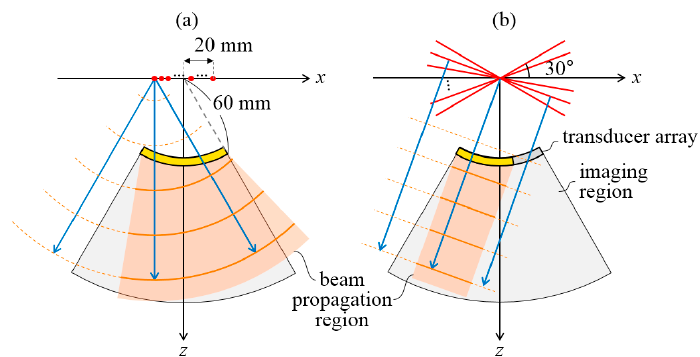
Figure 1. ( a ) Virtual sources (VSs) (red dots) and propagating DW (orange arcs) used for DWI and ( b ) steered PWs (solid red lines) and propagating PW (orange lines) used for PWI. Directions of DWs and PWs are indicated by blue arrows, and transmit apertures are marked with yellow shaded areas. Pixels in the beam propagation region (orange shaded area) for each DW or PW transmission should be reconstructed in the beamforming process. Difference in the size of beam propagation region between DWI and PWI shows the difference in the amount of computations required for DWI and PWI.